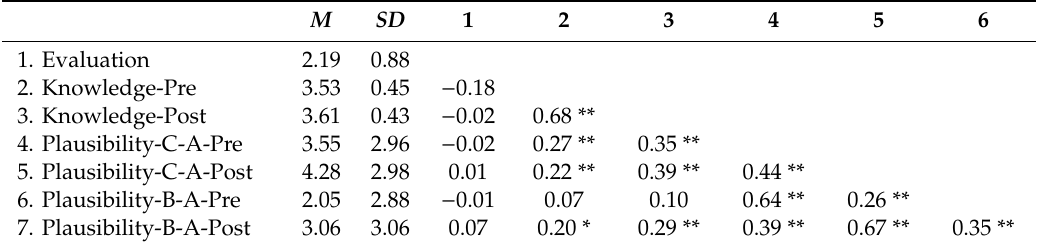
Table 2. Descriptive Statistics and Correlations between the Freshwater baMEL SEM latent variables.